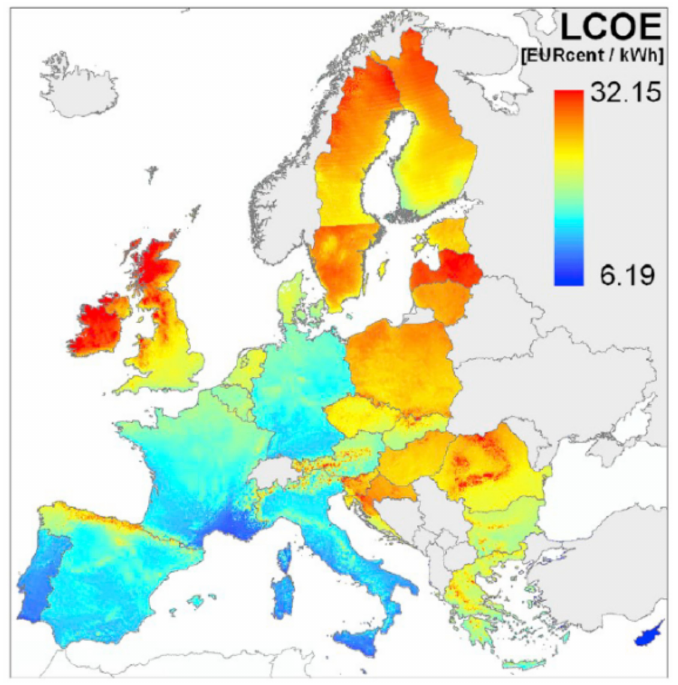
Figure 7. LCoE of PV-generated electricity in the EU as of 2019